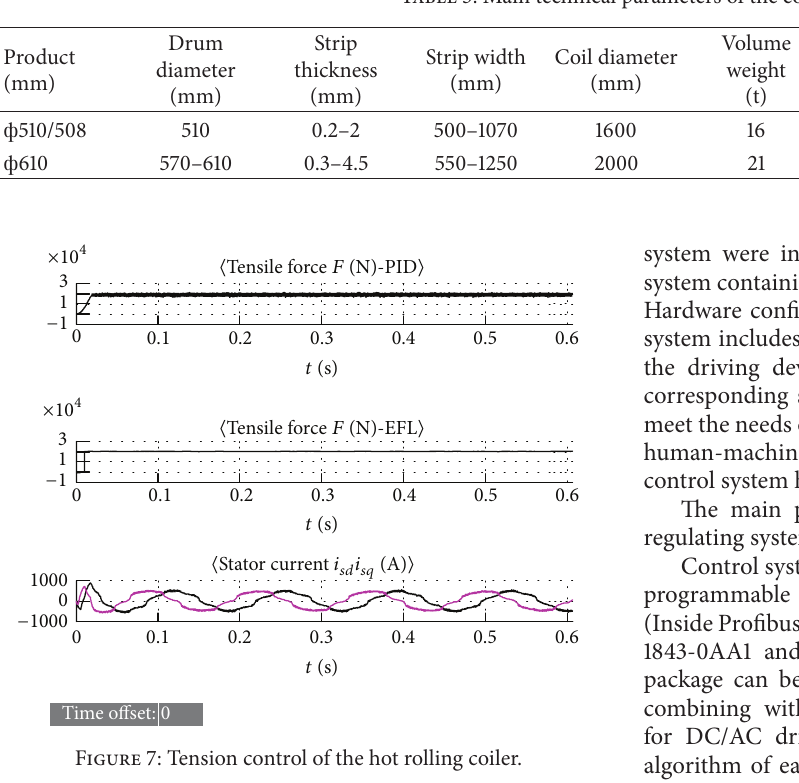
Table 3: Main technical parameters of the coiler.